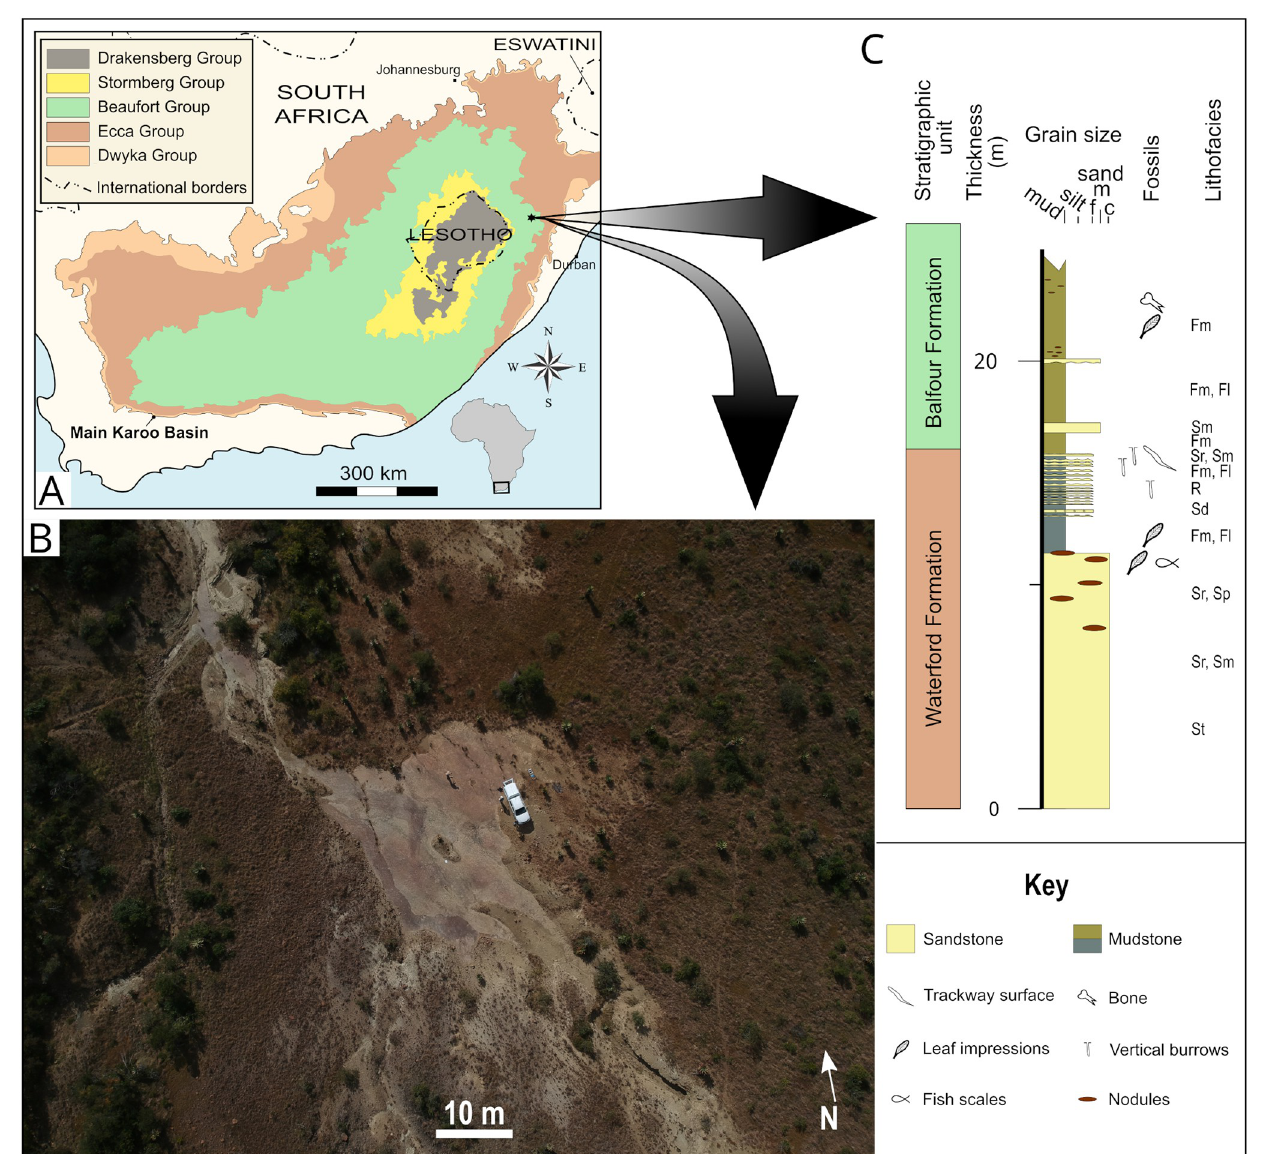
Fig 1. Geological setting of the Dave Green palaeosurface. A) Simplified geological map of the main Karoo Basin. Position of the study area is indicated. B) Aerial photo of the palaeosurface (taken by AK). C) Stratigraphic log measured along the Rensburgspruit.